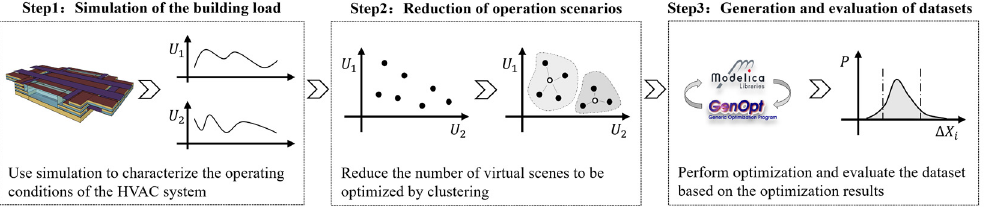
Figure 3. Method for constructing training dataset (U 1 and U 2 are descriptive variables of the system operation scenarios. There are more than two descriptive variables, but only two are shown in the diagram for the convenience of drawing).